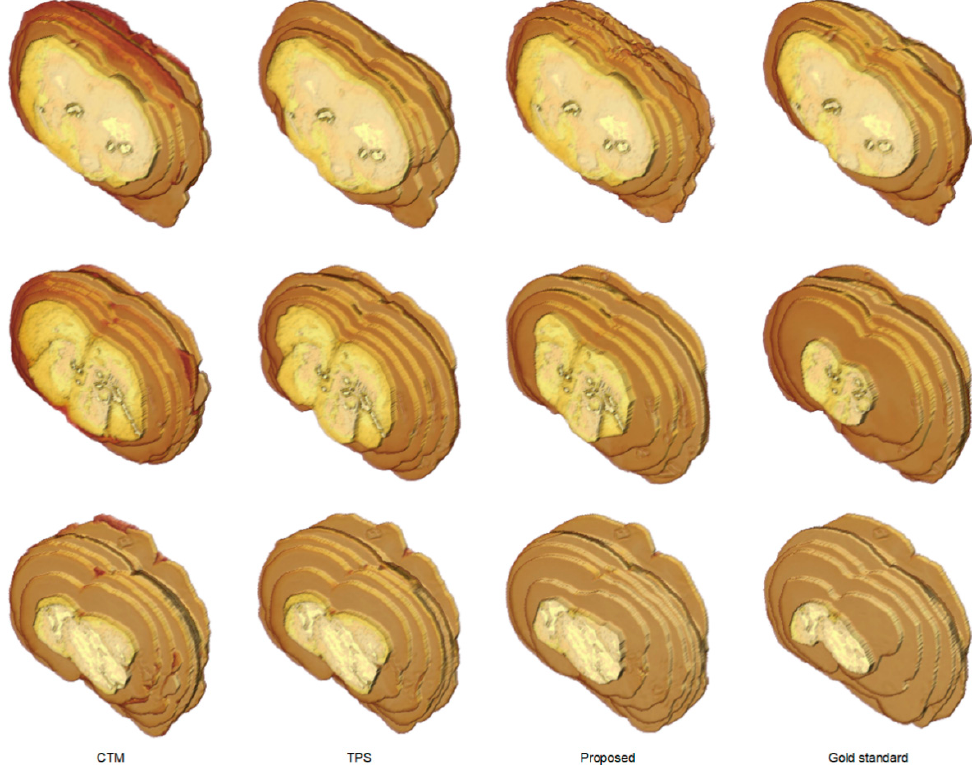
Figure 6. Visual comparison of rat brain extraction results in TTC-stained images using different methods in 3-D view. Top row: Subject 2. Middle row: Subject 20. Bottom row: Subject 37.